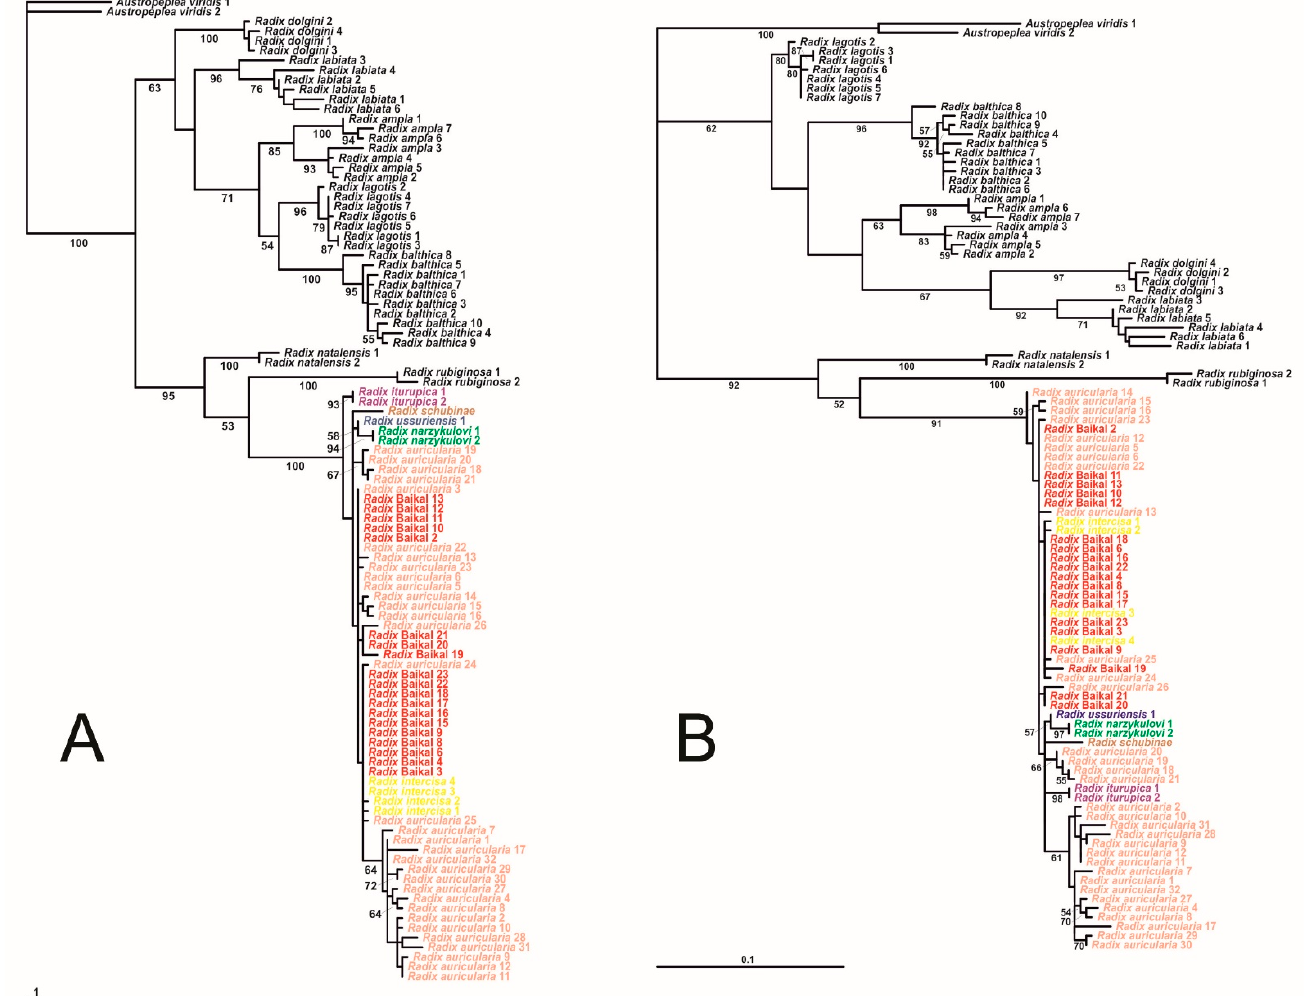
Figure 3. Hypotheses of the phylogenetic relationships of analysed Radix auricularia specimens based on the sequenced fragment (329 bp) of the mitochondrial cyt–b marker using different algorithms for tree building: ( A ) based on one of the 100,000 best maximum-parsimony (MP) trees (tree length = 415, CI = 0.5398, RI = 0.9068) and ( B ) based on RAxML. Branch lengths are proportional to the number of substitutions, and the overall topology corresponds to that of the strict consensus tree. Bootstrap support values above 50% are reported below nodes.